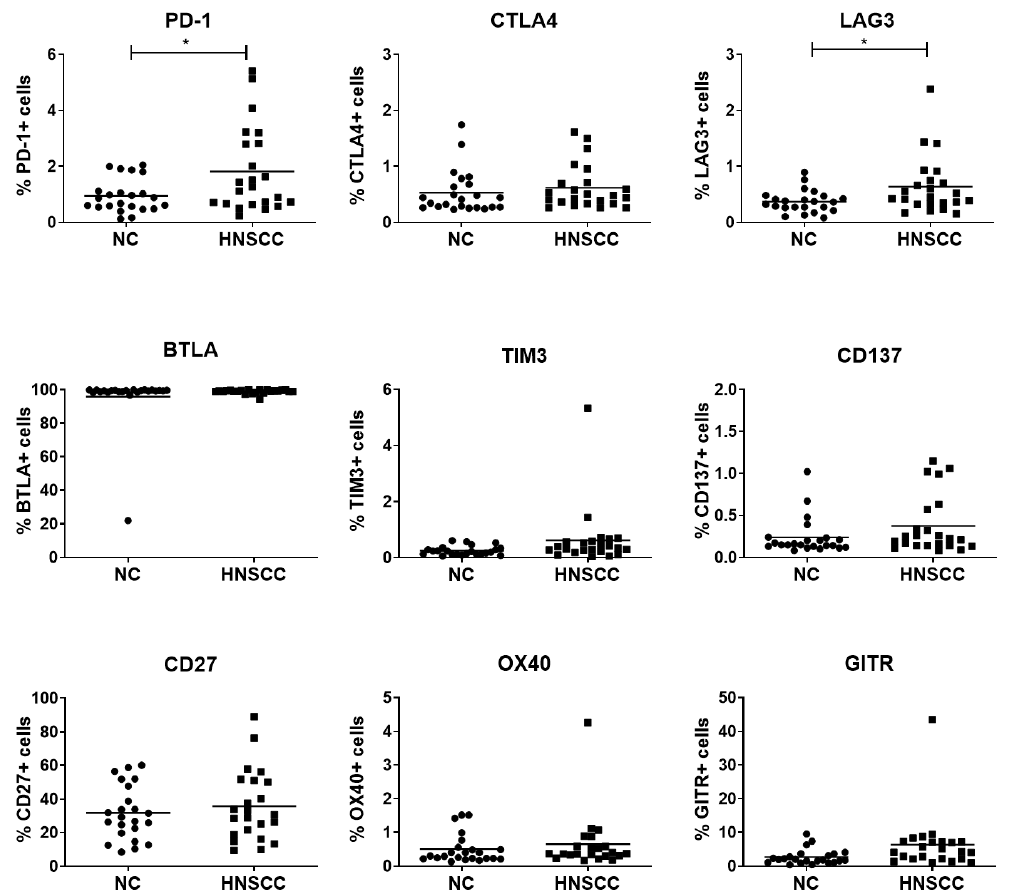
Figure 1. B cells were isolated from healthy individuals and HNSCC patients and analyzed by FACS. Shown is the frequency of cells expressing PD-1, CTLA-4, LAG3, BTLA, TIM3, CD137, CD27, OX40, and GITR. The expression of PD-1 and LAG3 was significantly increased in B cells isolated from HNSCC patients. n = 23, each dot represents a B cell sample from a separate individual. *: p < 0.05. HNSCC, B cells isolated from blood plasma of HNSCC patients. NC = no cancer, B cells isolated from blood plasma of healthy volunteers.